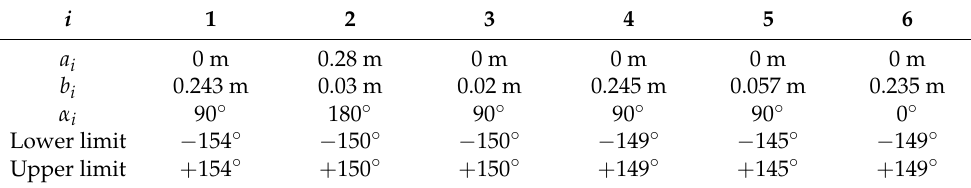
Table 3. Numerical parameters of Kinova Gen3 lite.